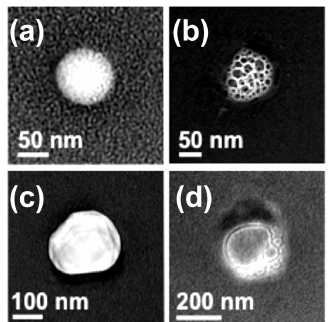
Figure 4. Examples for single particles observed with TEM: (a) a particle stable under the beam of the electron microscope; (b) a par- ticle with a skeletal structure typical for decomposed gel matter; (c) a particle stable under the electron beam; and (d) an example for a particle that is unstable under the electron